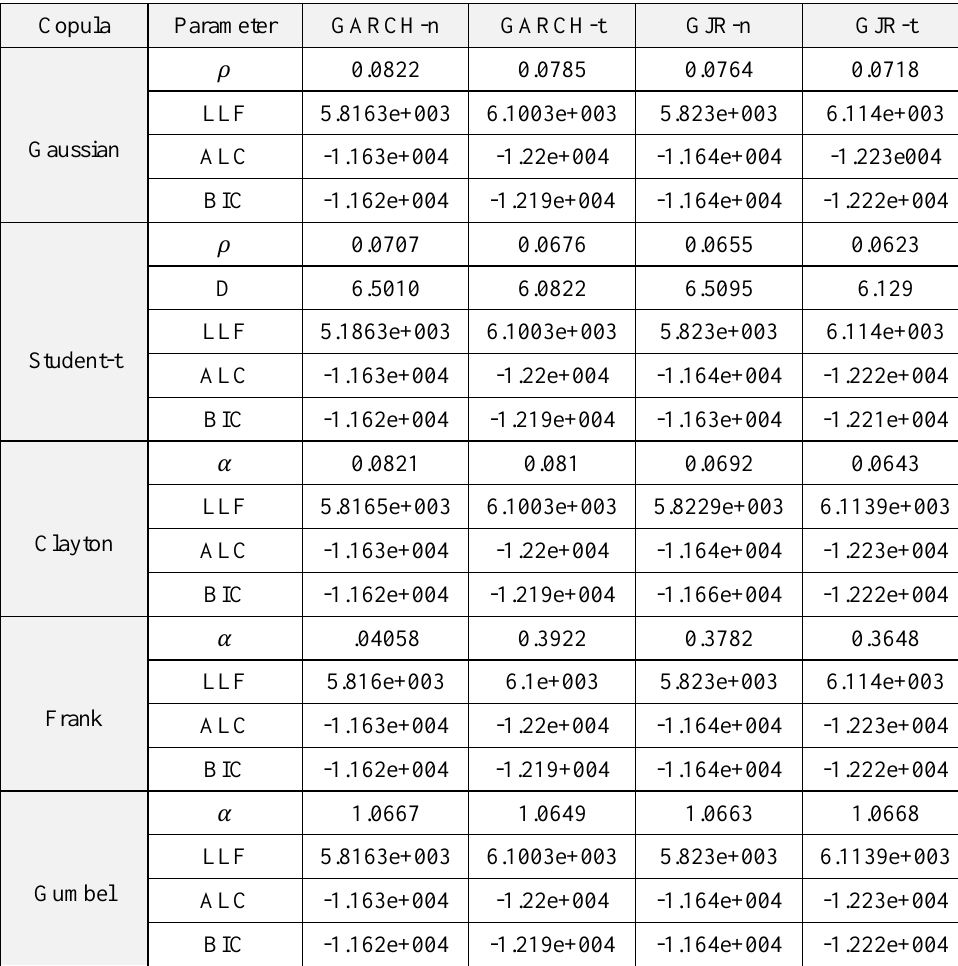
Table 4. Parameter estimates for families of copula and model selection